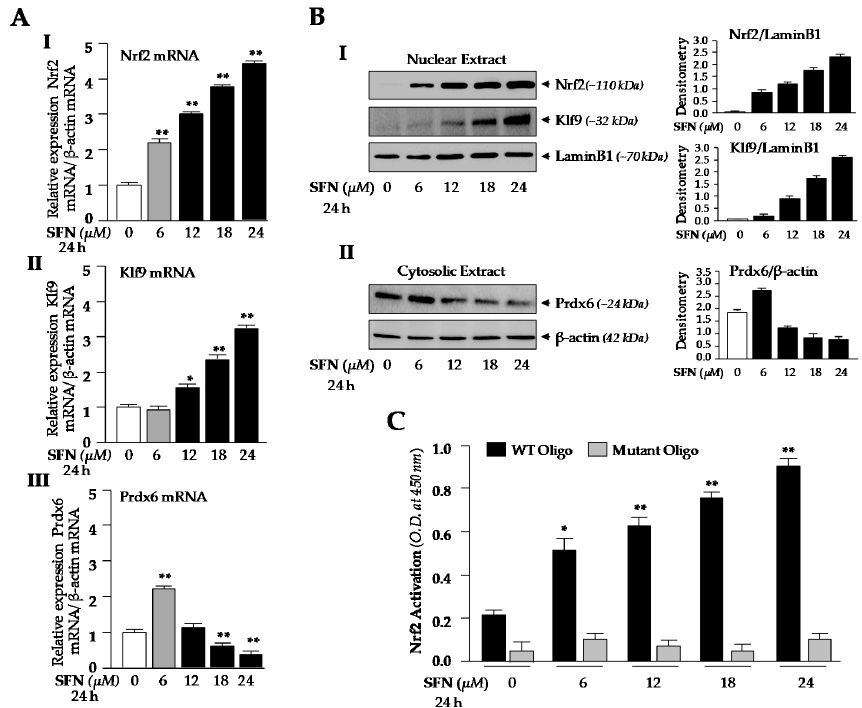
Figure 2. High dose of SFN increased expression of Nrf2 and Klf9 and reduced Prdx6 expression. ( A ) Cells were untreated or treated with increasing doses of SFN; non-toxic amount of SFN ( < 6 µ M) and higher doses of SFN ( > 12 µ M) as indicated. After 24 h, RT-qPCR was conducted using primers specific to Nrf2 (AI), Klf9 (AII) and Prdx6 (AIII). Experiments were conducted three times and data is represented as mean ± S.D. * p < 0.05, ** p < 0.001; SFN treated versus untreated (DMSO) control. ( B ) Nrf2 and Klf9 are overly accumulated in nucleus and inversely related to reduce abundance of Prdx6 protein in response to excessive amount of SFN. hLECs were treated or untreated with different doses of SFN as indicated. Nuclear (Nrf2 and Klf9) and cytosolic (for Prdx6) fractions were isolated. Samples containing equal amounts of protein were immunoblotted using an antibody specific to Nrf2, Klf9 and Prdx6, as shown. A dramatic nuclear accumulation of Nrf2 and Klf9 (BI) and reduction in Prdx6 expression (BII) were observed in response to increased concentrations of SFN treatment. Right adjacent panel reveals densitometry analysis of each protein bands. ( C ) SFN treated hLECs displayed significant increased Nrf2 activity. hLECs were treated with DMSO control or different concentration of SFN for 24 h, and nuclear extracts were analyzed for Nrf2-ARE (antioxidant responsive element) binding by ELISA (enzyme-linked immunosorbent assay). Nuclear extracts containing equal amounts of protein were processed and assayed for Nrf2 activity using a commercially available kit (Active motif) as described in Materials and Methods. The data represent the mean ± S.D. from three independent experiments. p values were determined SFN treated versus untreated (DMSO) control. * p < 0.05, ** p <